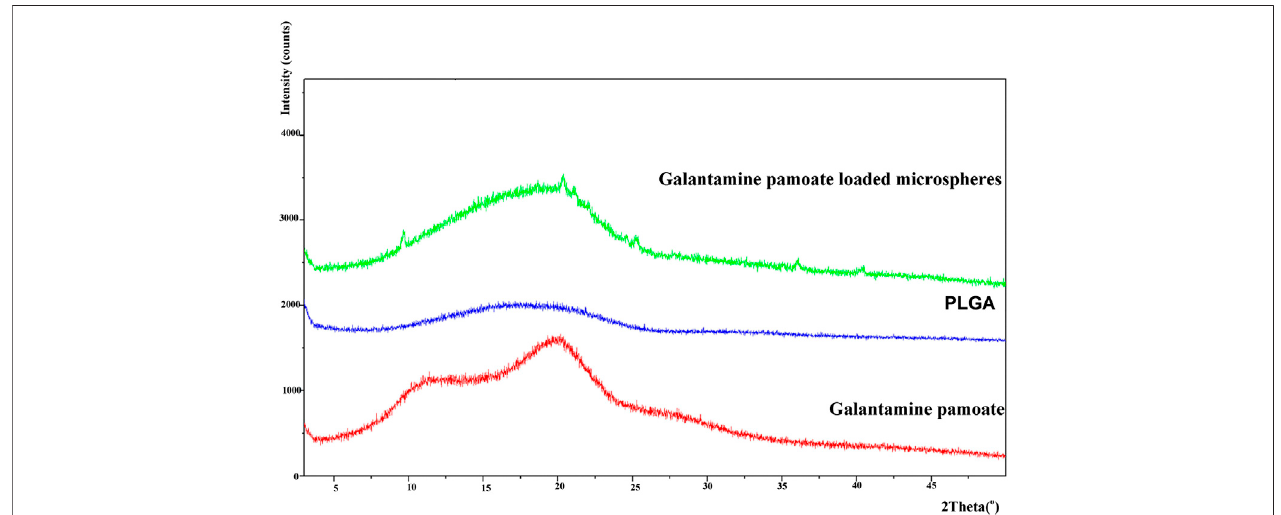
FIGURE 6 | X-ray diffractogram of GLT-PM, PLGA and GLT-PM-MS.